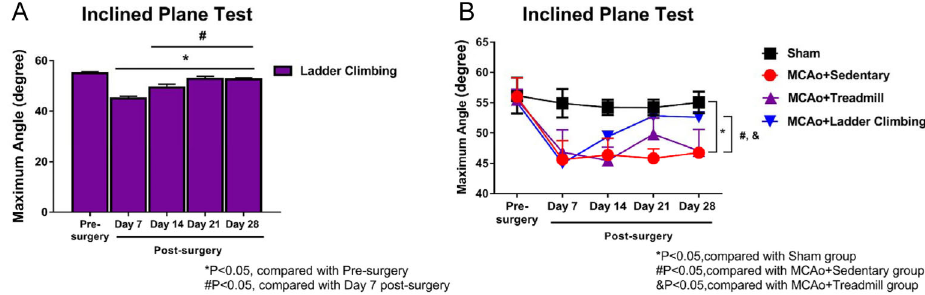
Figure 9. Hind limb grip measured in angles in the weekly inclined plane test for 28 days after stroke rehabilitation in sham rats and rats with middle cerebral artery occlusion (MCAo) submitted to different exercise protocols. A , Angles of the inclined plane of the climbing group at each week. B, Inclined plane angle of each group at each week. Data are reported as means ± SD (ANOVA and t